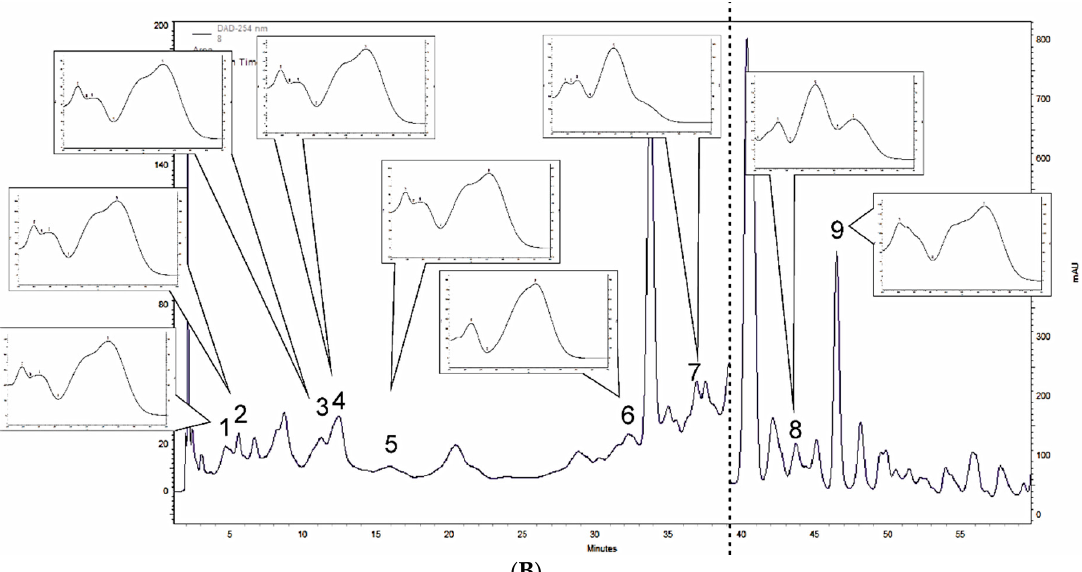
Figure 1. Examples of high-performance liquid chromatography with diode-array detection (HPLC-DAD) chromatographic separation ( λ = 254 nm) for the leaf extracts of ( A ) Mentha × piperita (1—protocatechuic acid; 2—cryptochlorogenic acid; 3—chlorogenic acid; 4—caffeic acid; 5—